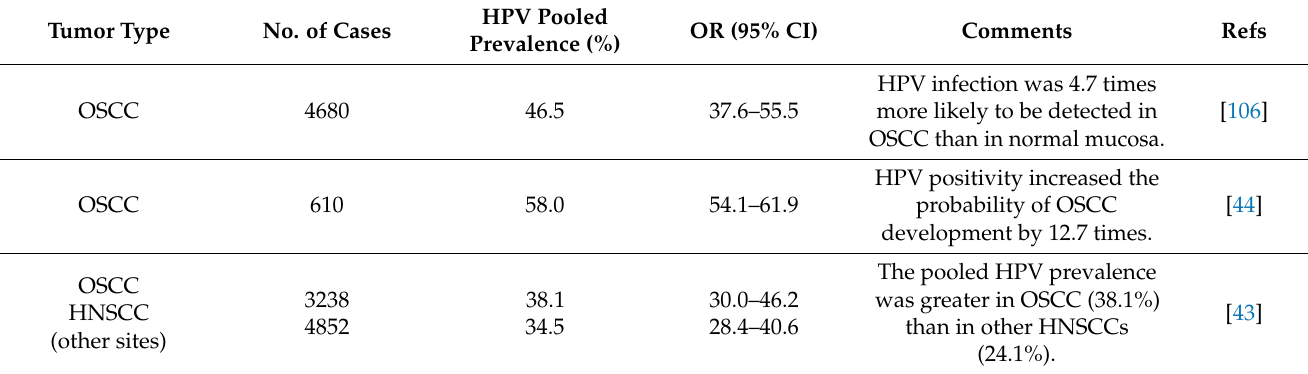
Table 2. HPV prevalence in HNSCC according to meta-analysis